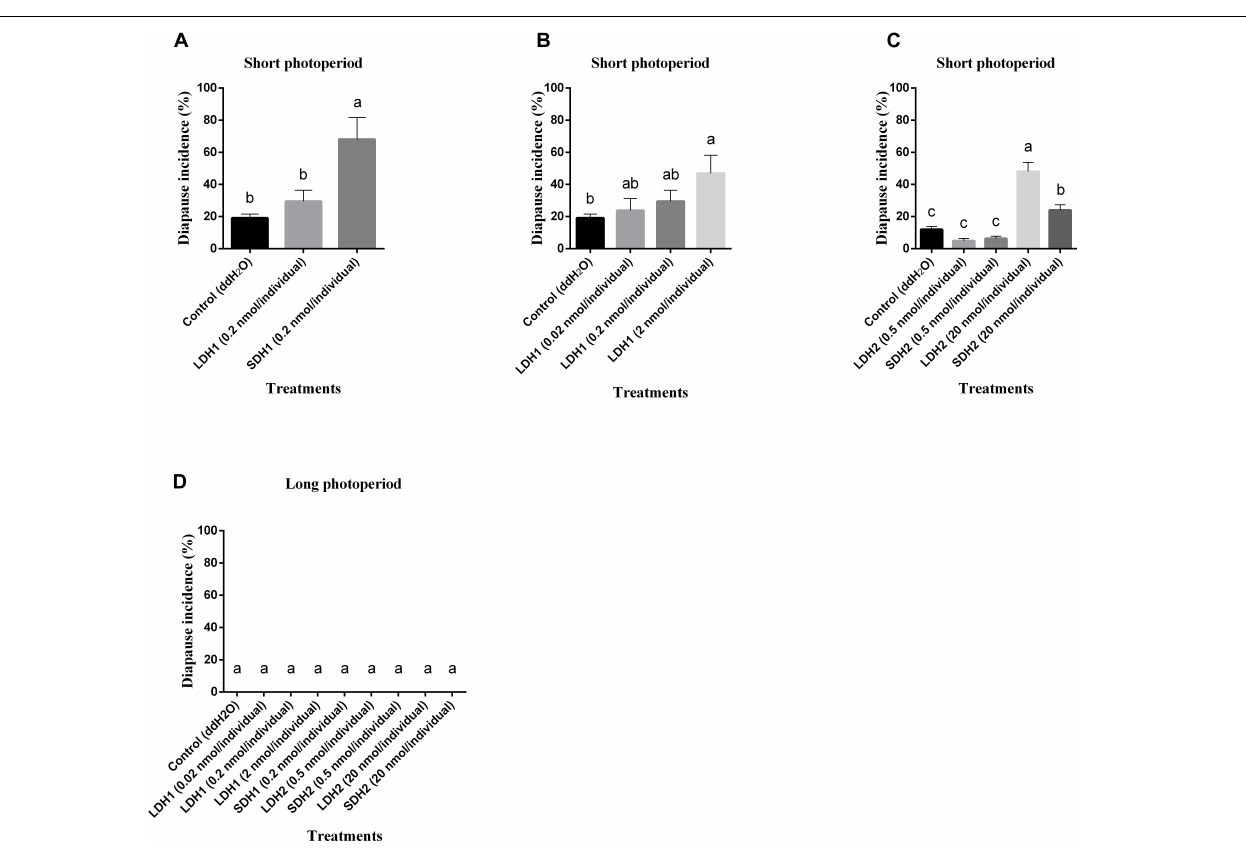
FIGURE 3 | Diapause incidence of L. migratoria eggs after treatment of female parent with selected doses of LDH1 (MHSKNVVVQRCIQTGFSDGGSIRNVPETSLWF GPRIa), SDH1 (LWFGPRIa), LDH2 (SNPETNLWFGPRVa) and SDH2 (LWFGPRVa). (A) Injection of 0.2 nmol/individual of LDH1 or SDH1 at 10:14 L:D and 28 ◦ C. (B) Injection of 0.02, 0.2, and 2 nmol/individual LDH1 under 10:14 L:D and 28 ◦ C. (C) Injection of 0.5 and 20 nmol/individual of LDH2 or SDH2 under 10:14 L:D and 28 ◦ C. (D) Injection of 0.02, 0.2, and 2 nmol/individual LDH1, 0.2 nmol/individual of SDH1, 0.5, and 20 nmol/individual of LDH2 or SDH2 at 16:8 L:D and 28 ◦ C. Control treatment was injection of distilled water (control). The lowercase a, b, and c indicated that statistically significant difference of diapause incidence was considered on an error probability of p < 0.05 by one-way ANOVA using Duncan’s multiple-range